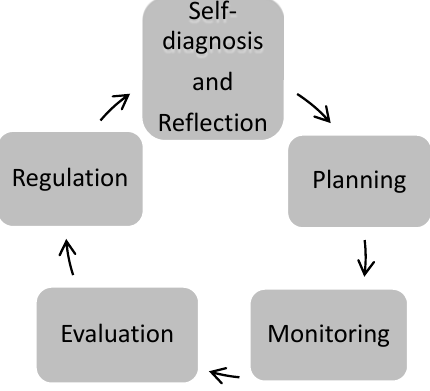
Figure 1. Metacognitive learning cycle.